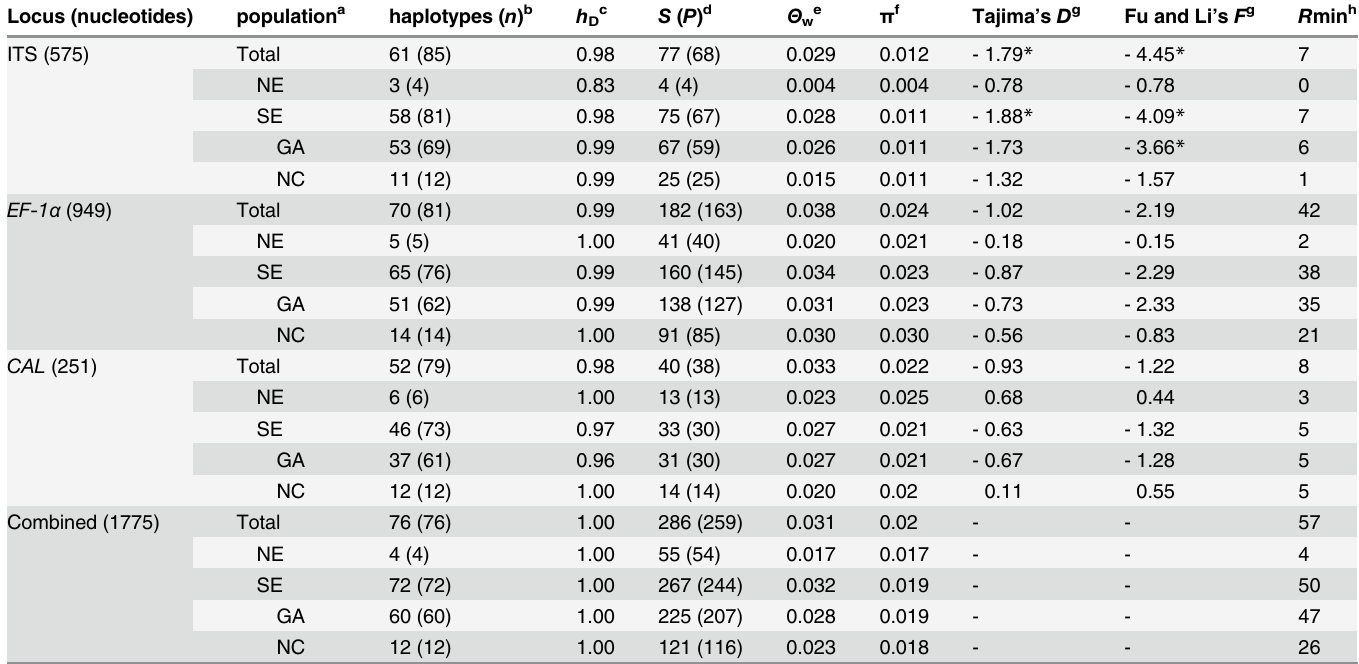
Table 2. Number of haplotypes, haplotype diversity, segregating sites, nucleotide diversity, population mutation rate, neutrality estimates, and minimum number of recombination events for each locus in the total population of Exobasidium maculosum collected from blueberry and from each geographic subpopulation. Locus